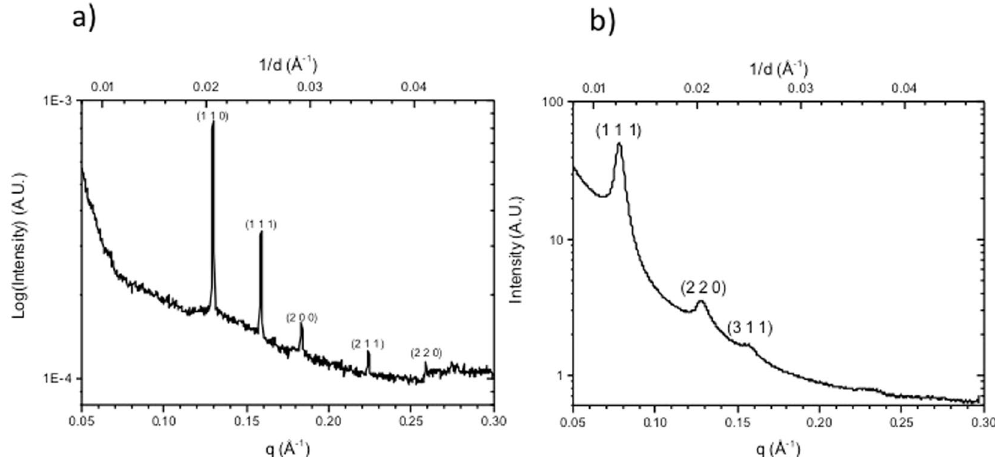
Figure 4. ( a ) 1D integrated SAXS patterns of a phytantriol coated gold foil immersed in 100 mM Bi(NO 3 ) 3 , 100 mM Na 2 S 2 O 3 and 200 mM EDTA in deionised water and ( b ) of a bismuth sulphide film electrodeposited through a phytantriol template. The film was deposited potentiostatically at a potential of − 0.4 V vs. SCE for 4